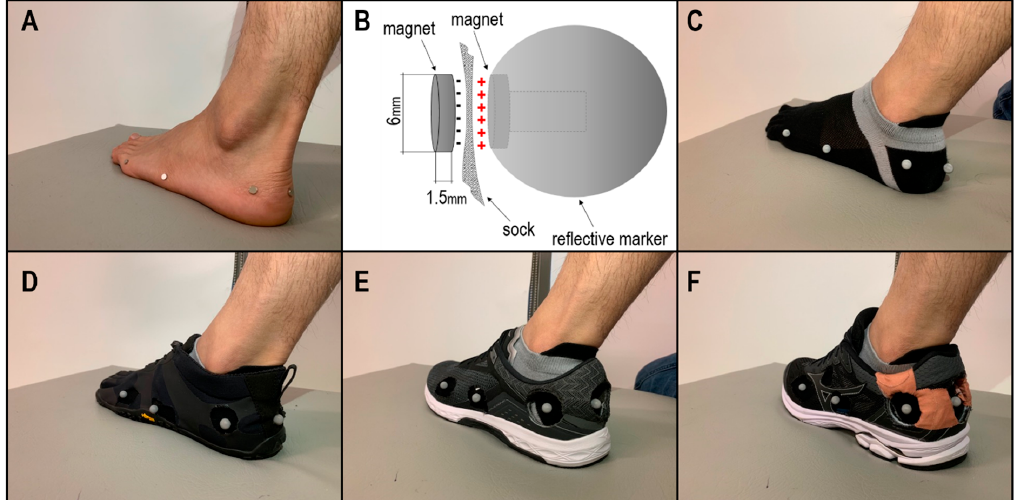
Figure A1. ( A ) Magnets glued to bony landmarks; ( B ) Schematic representation of